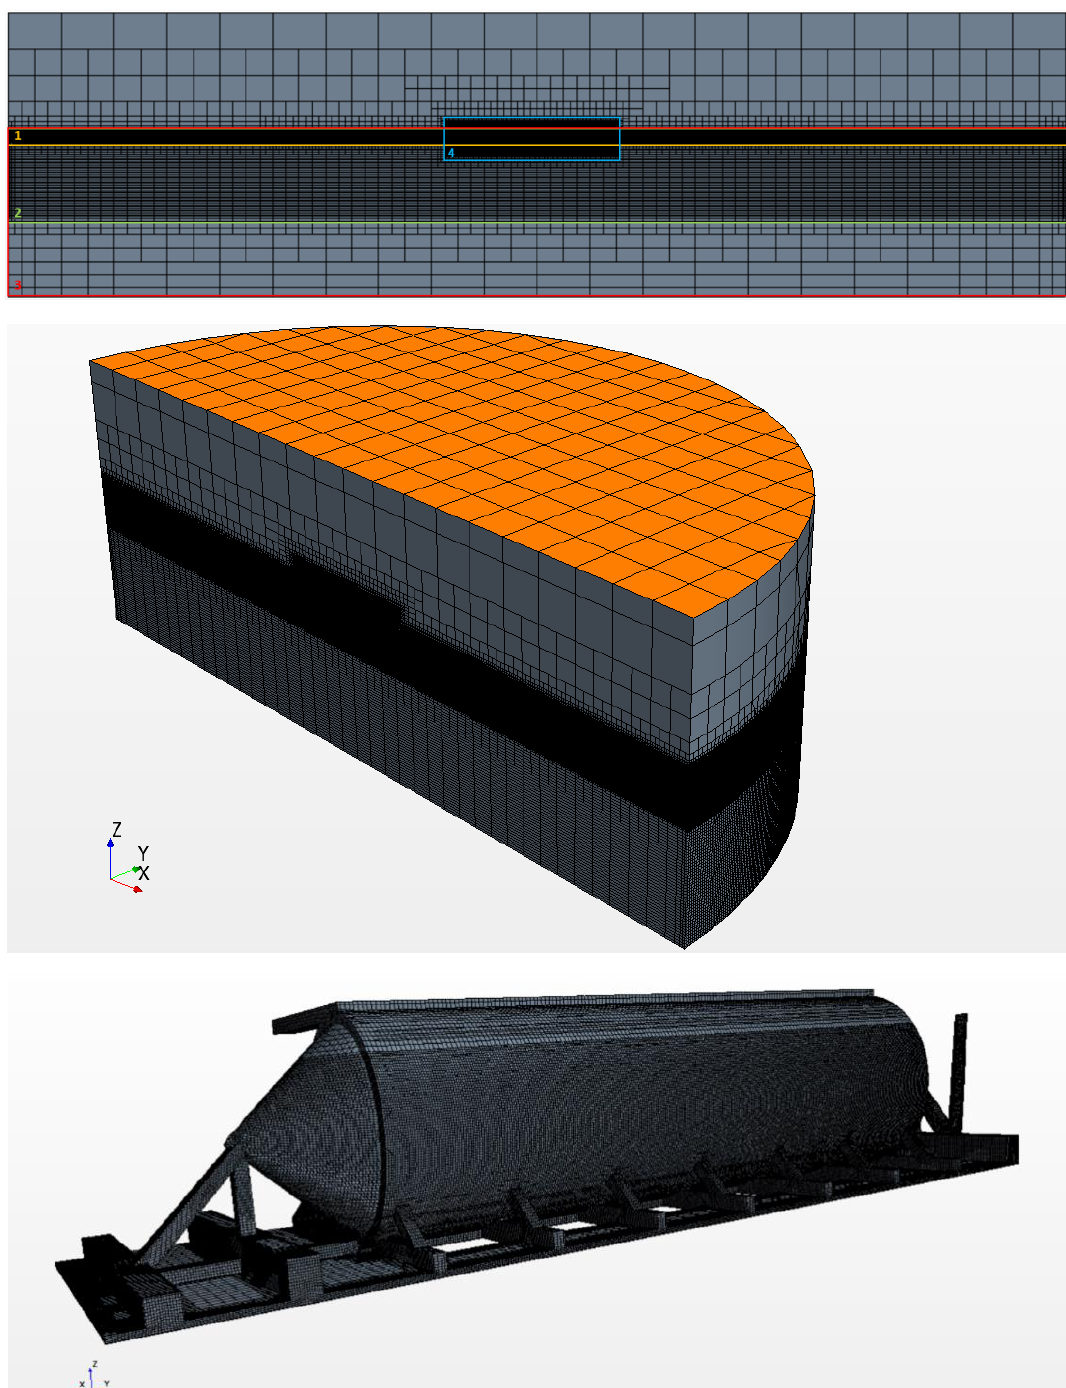
Figure 1. Section with the different sub-volumes used in the background mesh ( top ) and the general volume of study ( mid ) and details of the geometry simulated ( bottom ).